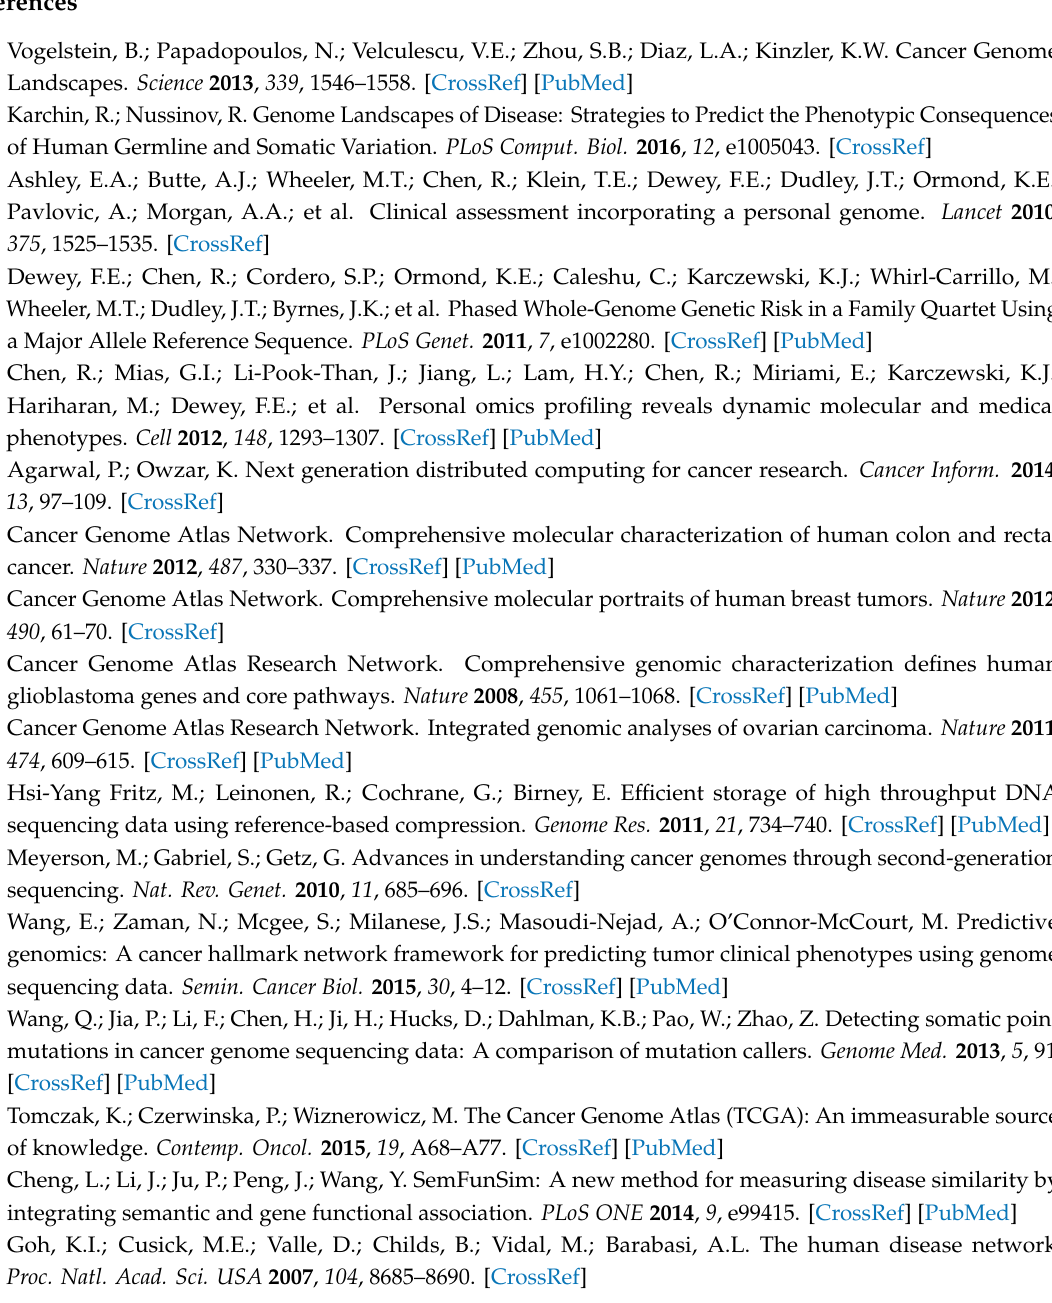
decay, (c) Transcriptional regulation of pluripotent stem cells pathways. Table S1: Identification of 76 prognostic biomarker pathways in 16 cancer types. Table S2: The number of same prognostic biomarker pathways among 16 cancer type. Table S3: Identification of prognostic biomarker pathways in breast cancer subtypes. Table S4: The degree of genes in the relevant prognostic pathways. Table S5: Top ten pathways di ff erentiated between tumor and normal by iPS, GSVA and ssGSEA in BRCA. Table S6: Top ten pathways di ff erentiated between tumor and normal by iPS, GSVA and ssGSEA in